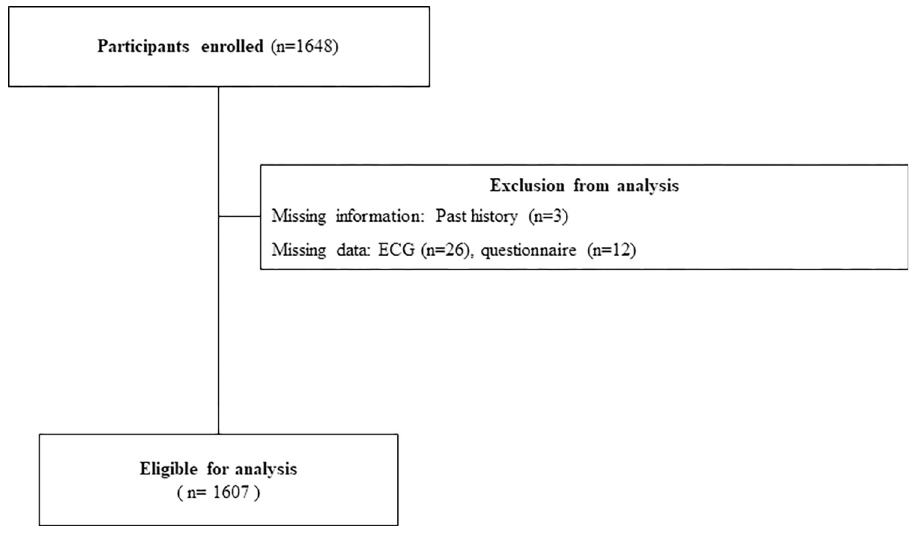
Fig 1. Flow chart of the